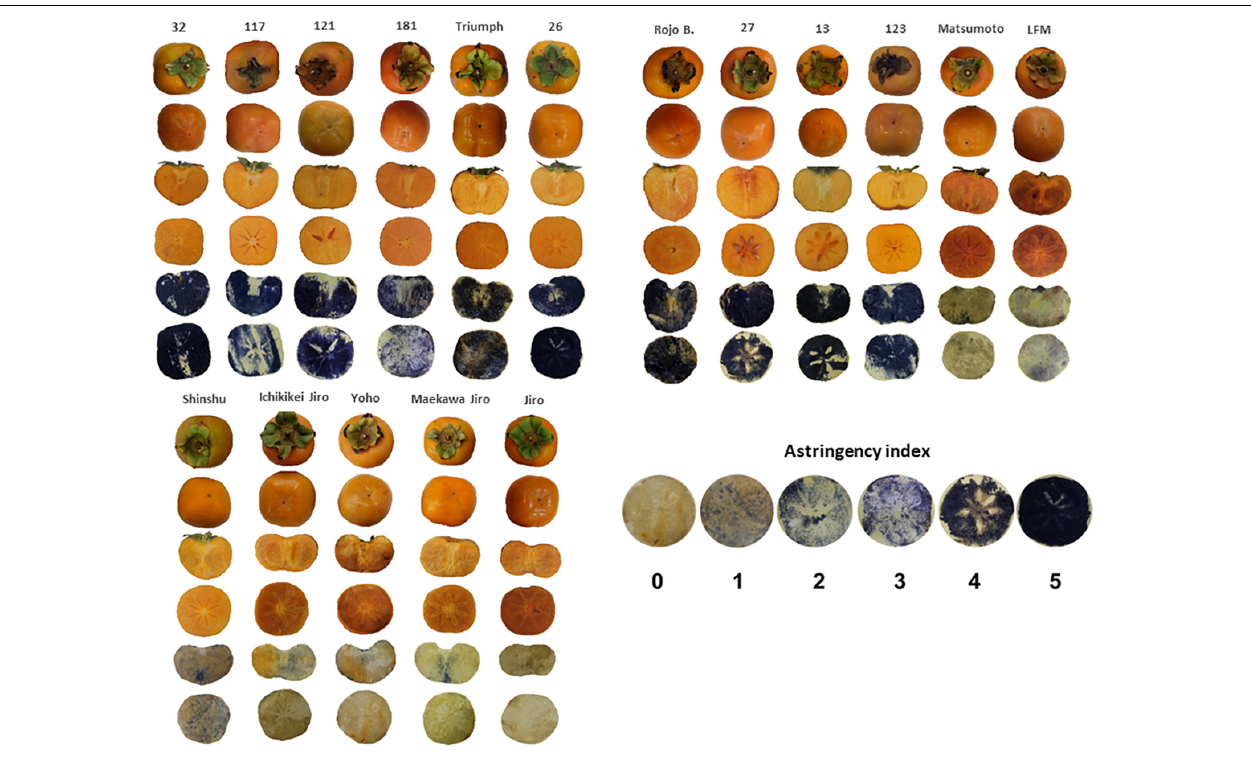
FIGURE 1 | Representative pictures of the persimmon cultivars showing the shape, and astringency imprint. The astringency index scale represents the incrementing scale of astringency based on FeCl 3 staining. Dark imprint represents high astringency (rank 5) and light color non-astringency (rank 0).